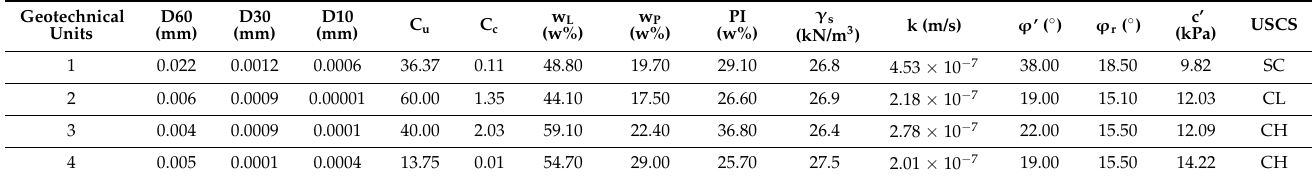
Table 1. Table reporting lithotechnical parameters obtained by laboratory tests and in accordance with pre-existing DBs (friction angles and cohesion). USCS classification of the four geotechnical units adopted for the soil covers are